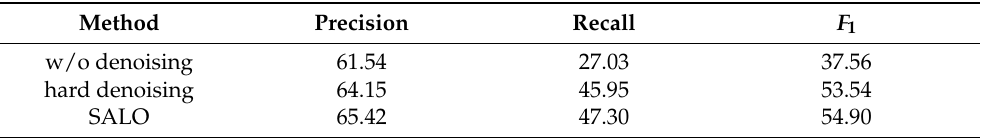
Table 2. The effectiveness of implicit noise denoising on Webpage: Precision, Recall and F 1 score (in %). Basemodel: